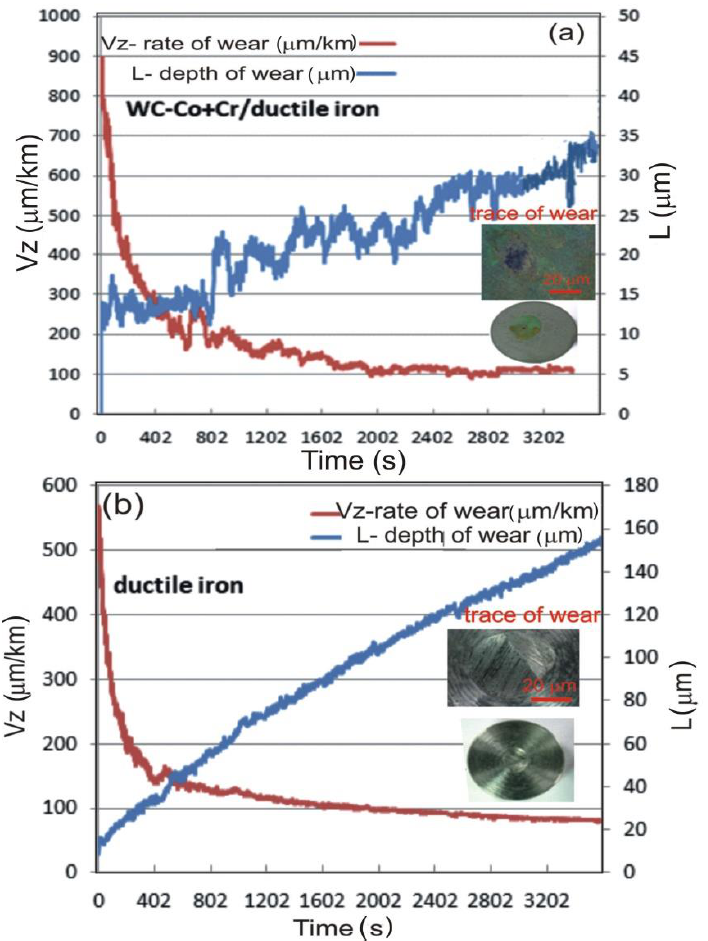
Figure 11. The results of the wear resistance tests of: ( a ) (WC – Co + Cr/ductile cast; ( b ) ductile cast iron.